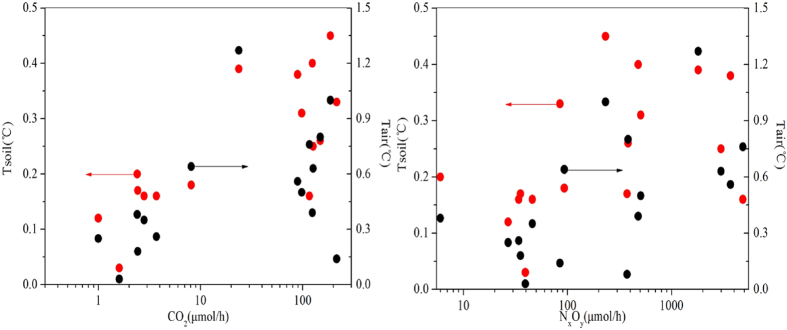
Responses of soil and air temperatures in the sealed chamber to the variation of CO2 and NxOy emission rates.